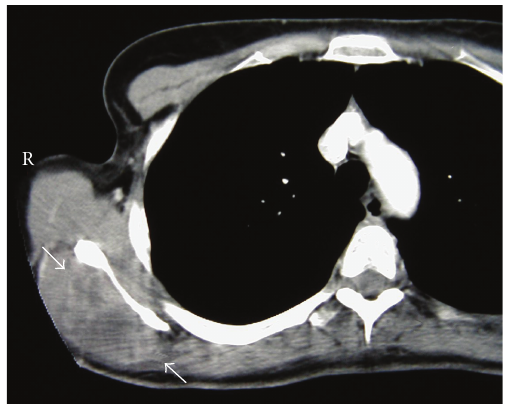
Figure 1: CT scan of the right scapula demonstrating a tumor in the infraspinatus fossa (arrows).